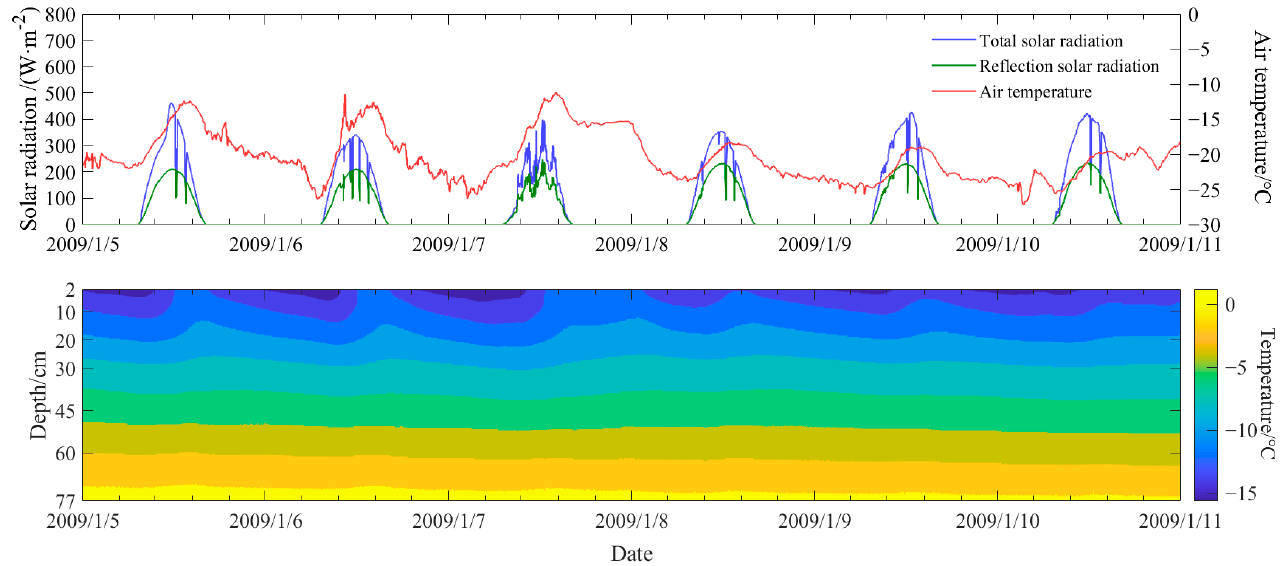
Figure 2. Measured process curves of air temperature, total solar radiation, reflected solar radiation, and ice/water temperature of Hongqipao Reservoir from 1 to 5 January 2009 (modified from Ref. [46]).